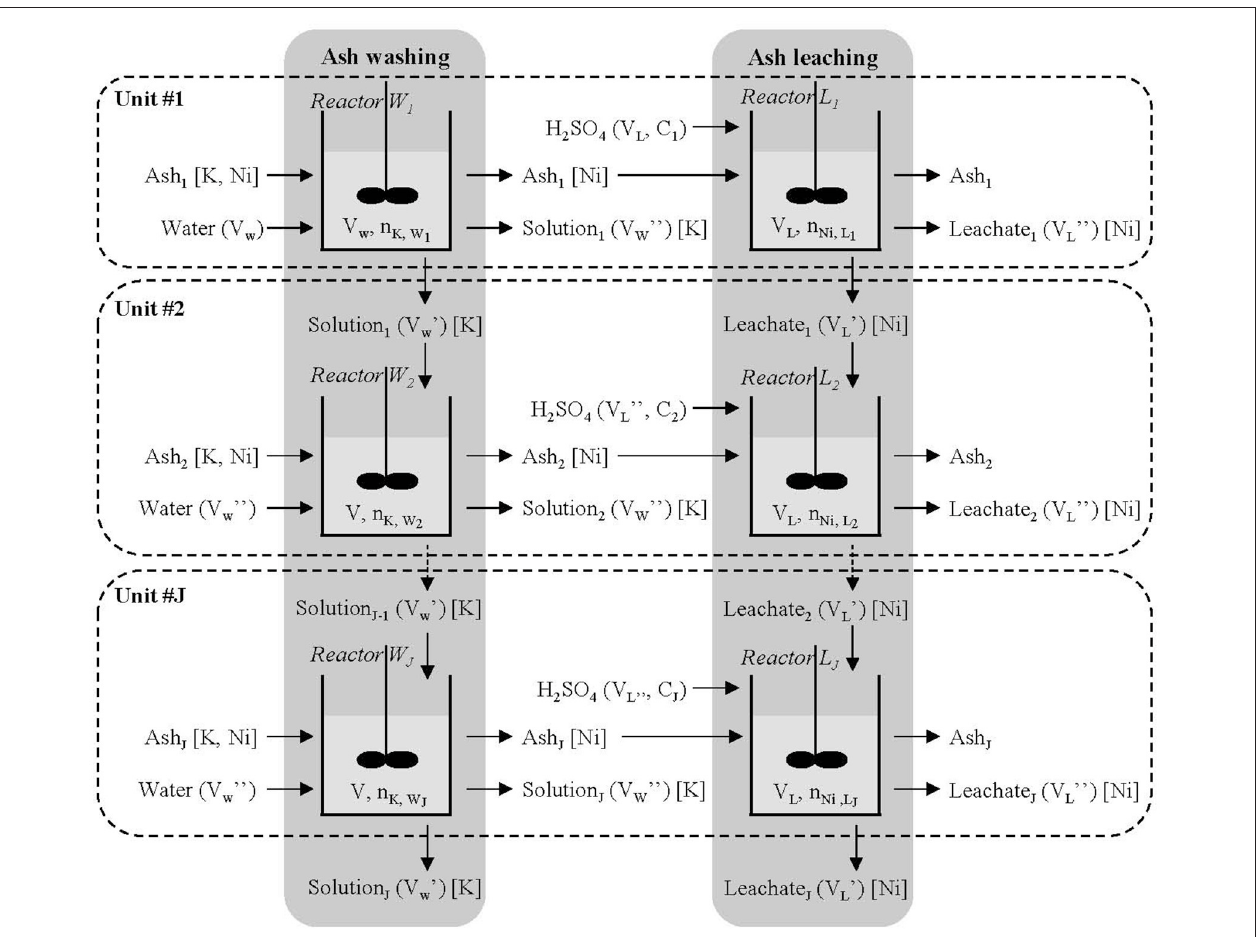
FIGURE 7 | Parallel batch configuration for Odontarrhena muralis s.l. ash washing and leaching. Liquid properties are indicated in brackets and targeted elements in square